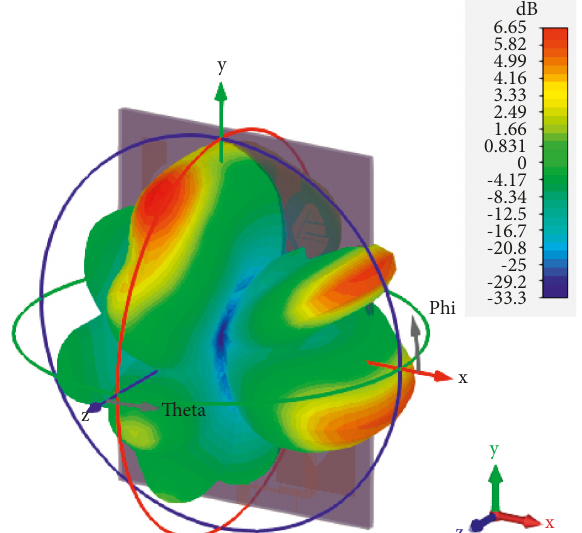
Figure 28: 3D radiation pattern (2 × 2 array).